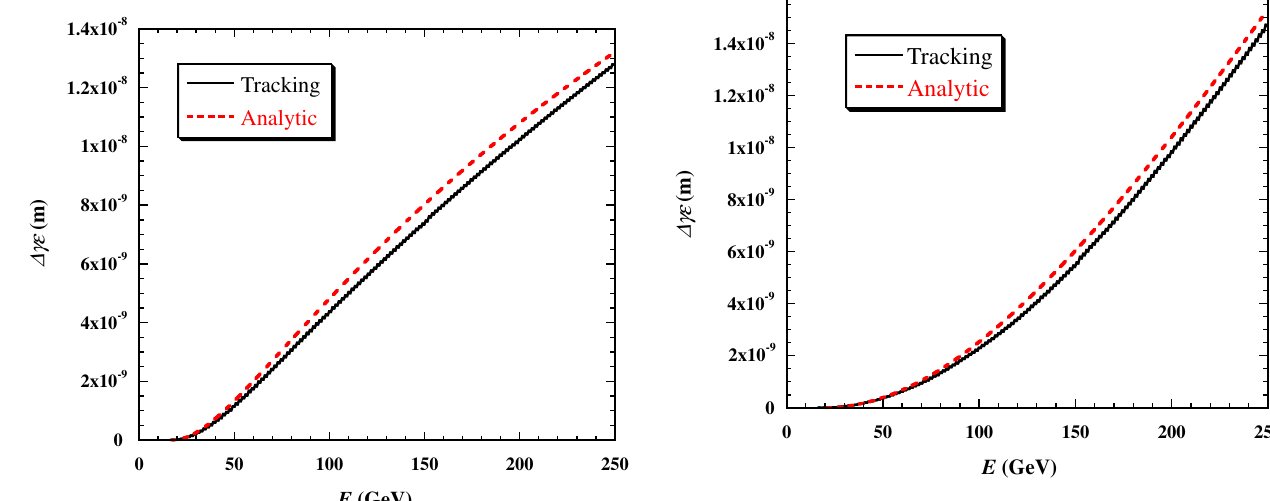
FIG. 4. Emittance growth induced by quadrupole magnet off- set 1 (cid:10) m (RMS), as a function of beam energy. Results of tracking simulation (solid line) and the analytic formula (dashed line) for the ILC main linac.